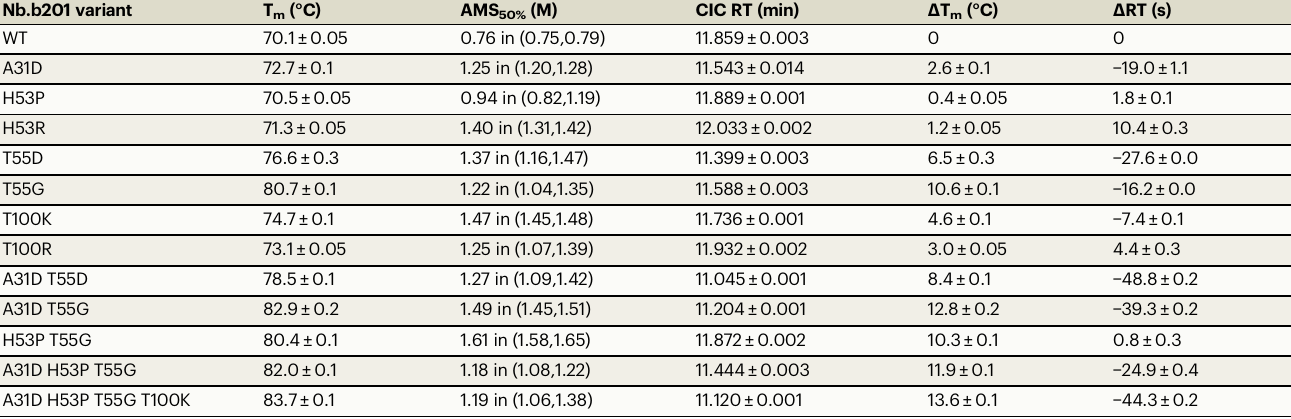
Table 1 | Experimentally characterised designed Nb.b201